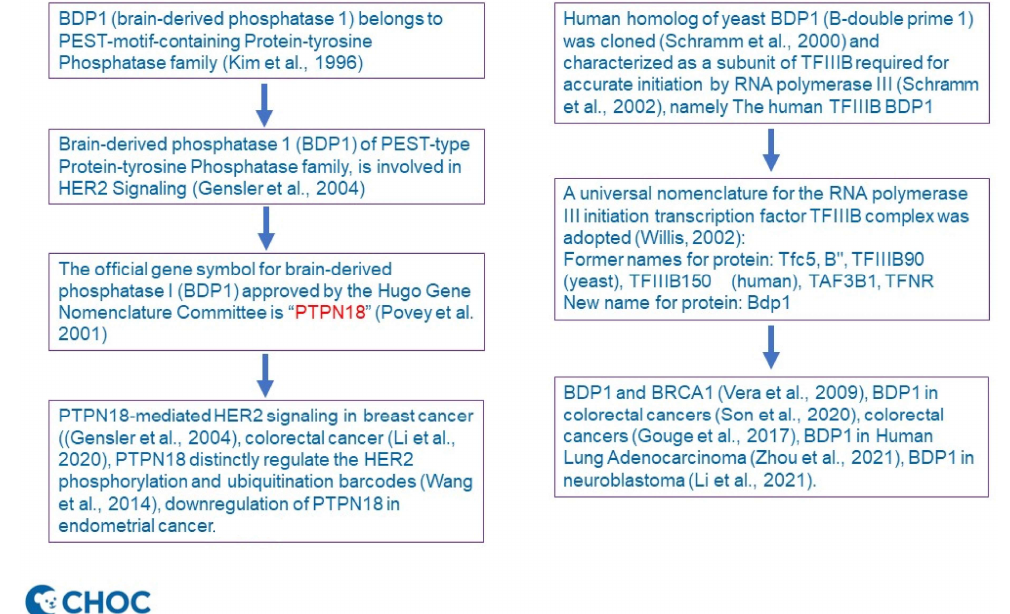
Figure 1. Illustrating the timeline of nomenclature and difference between PTPN18 and BDP1 and their perspective involvement in cancer (refer to citations References [1,2,5–16] for